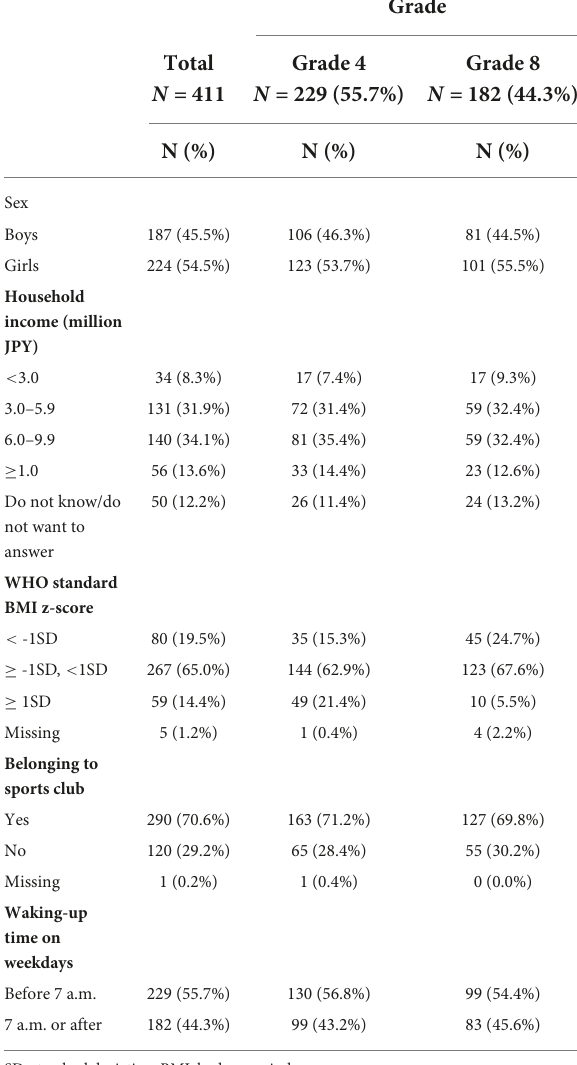
TABLE 1 Demographic characteristics of the study participants ( N =